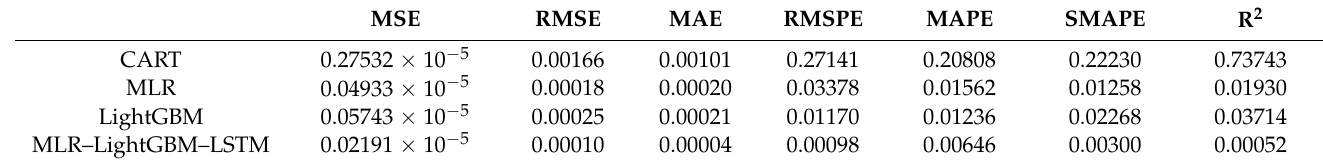
Table 6. Error Variance (obtained through Tables 4 and 5).